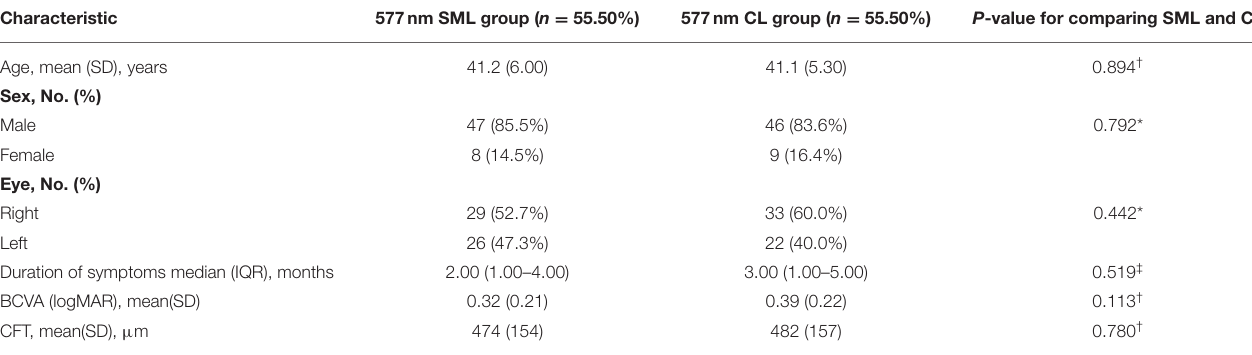
TABLE 1 | Baseline demographics and clinical characteristics by treatment group ( N = 110).